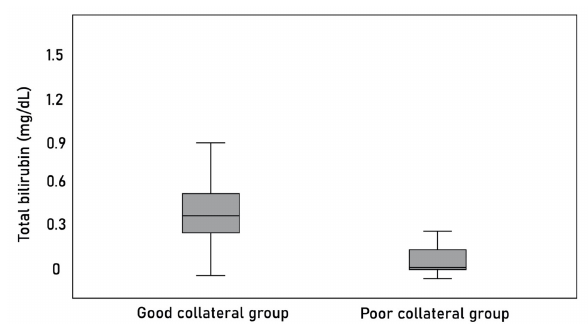
Fig. 1. Comparison of serum bilirubin levels in good and poor collateral groups.